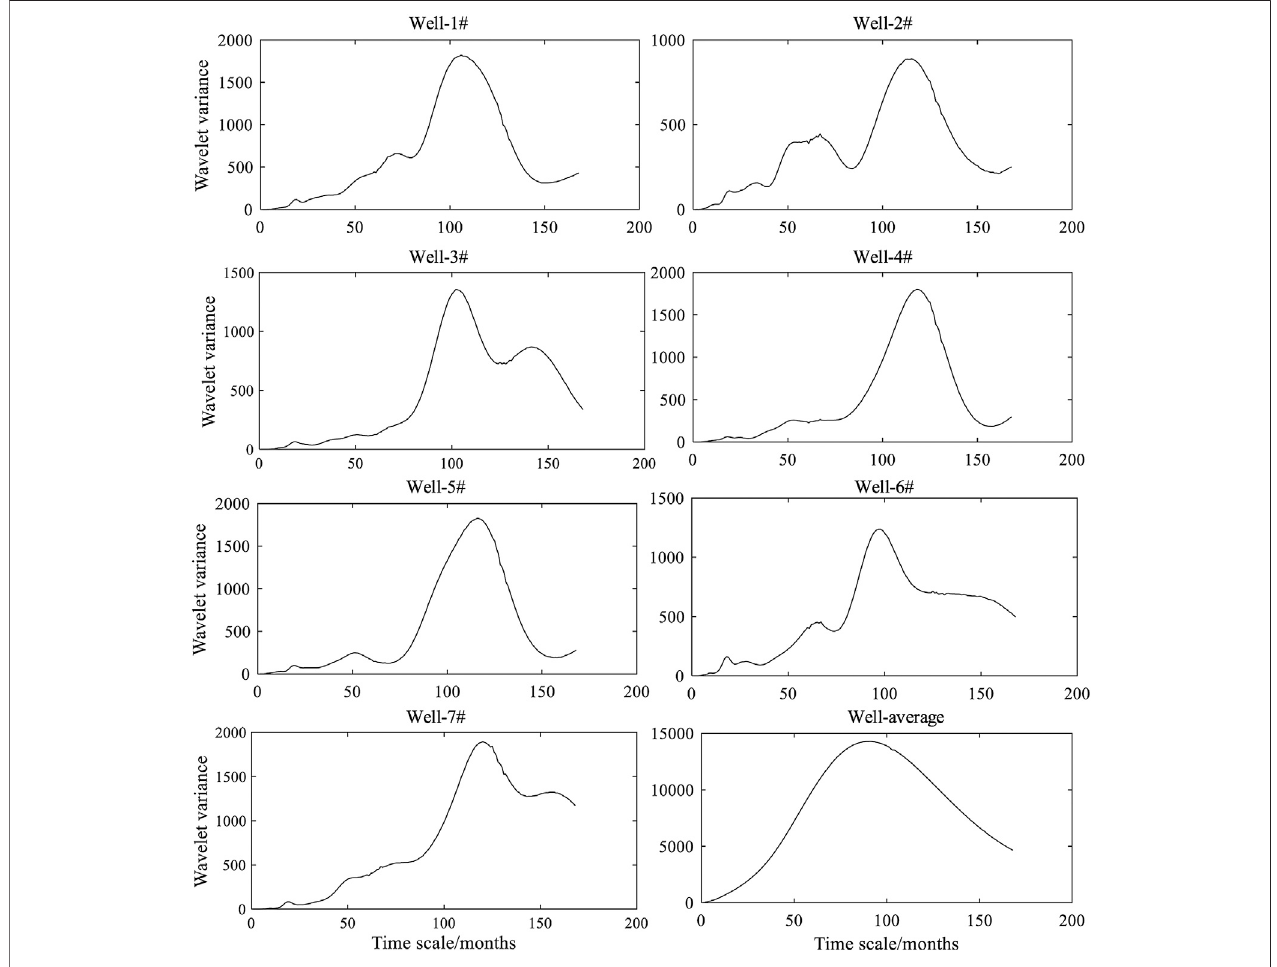
FIGURE 6 | Wavelet variance